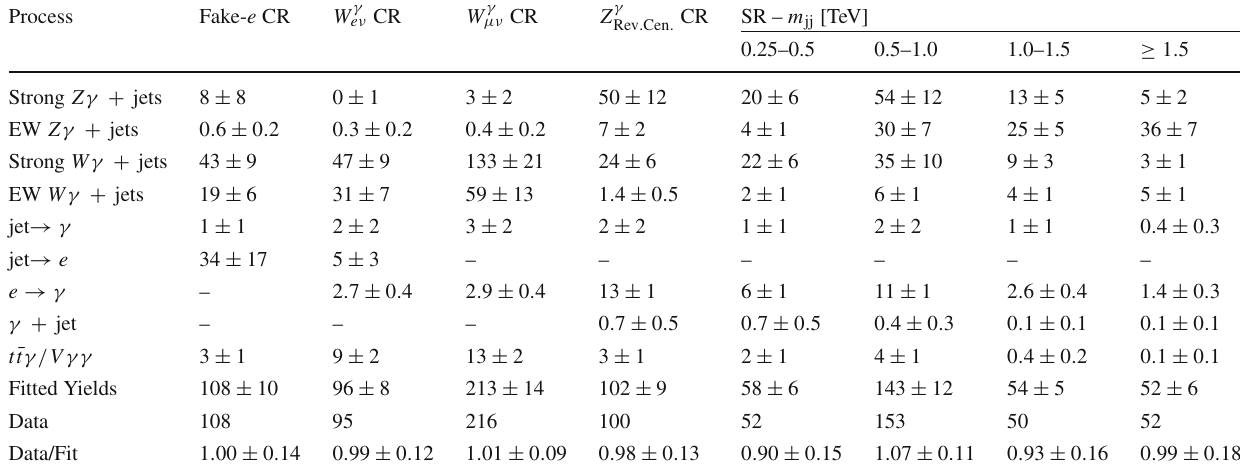
Table 5 Data yields and fitted predictions, after the fit to 139fb − 1 of in the SM processes are derived by the fit and include the effects of nui-